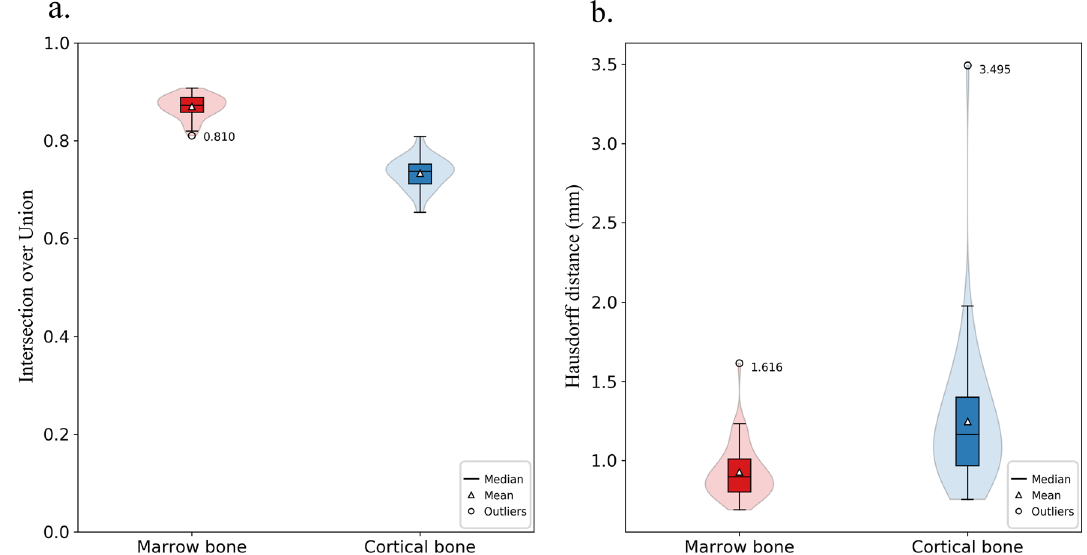
Figure 6. Box and violin plots of the performance metrics (IoU and the Hausdorff distance) obtained during cross-validation experiments. The black dots and their values represent outliers.